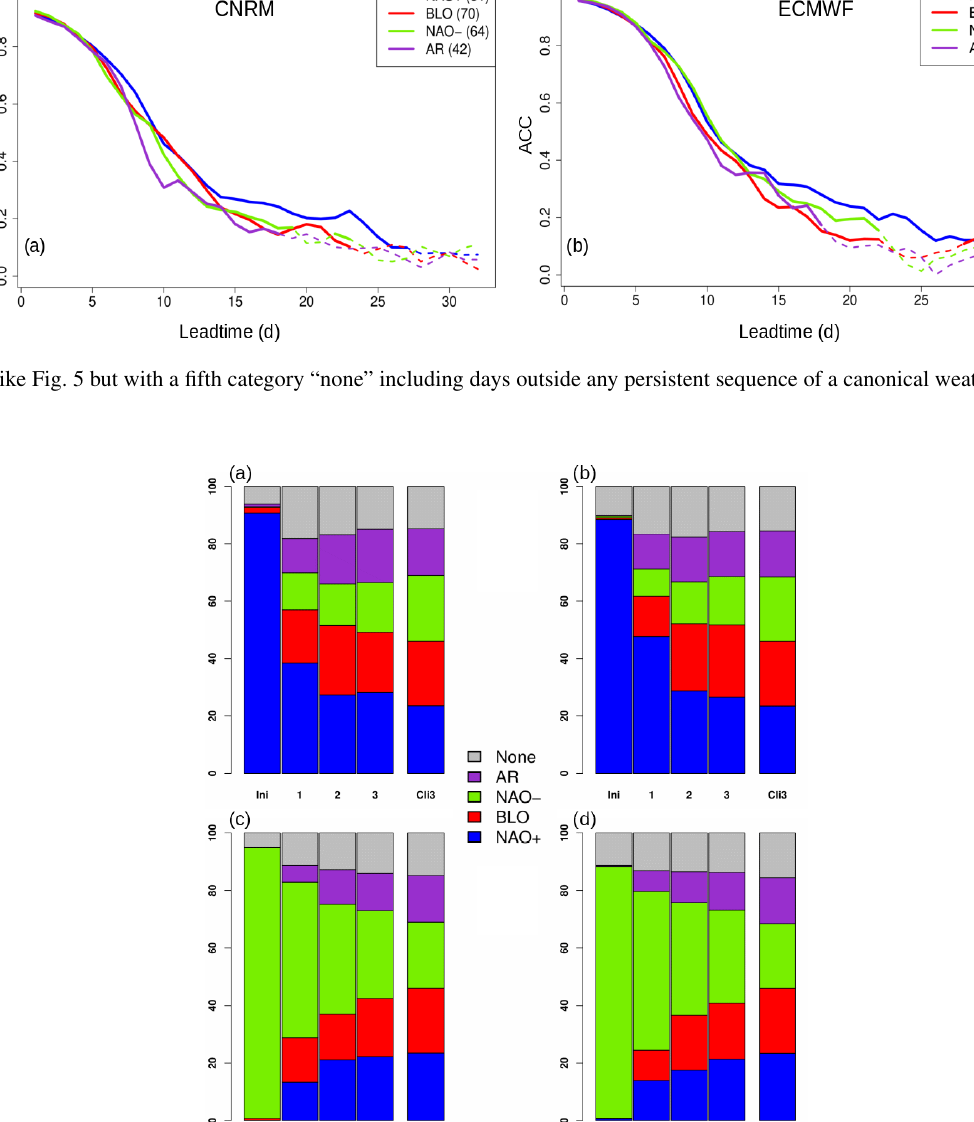
Weather Clim. Dynam., 2, 1033–1049, 2021